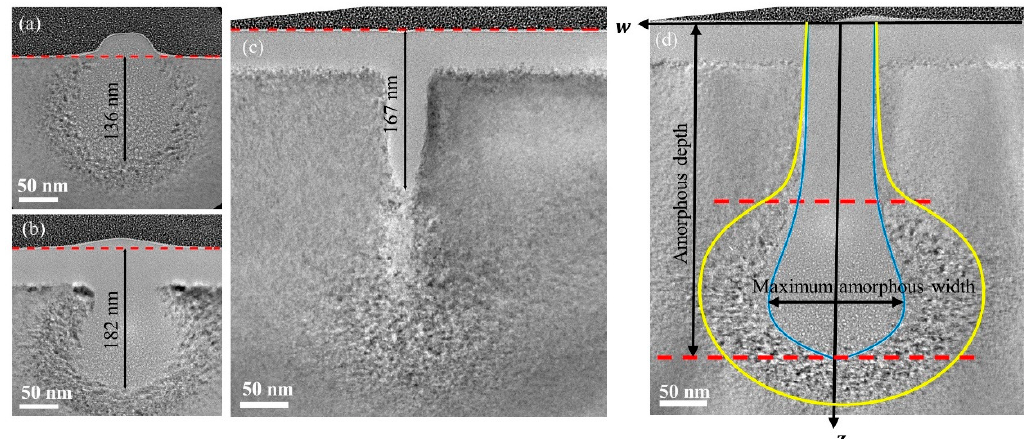
Figure 3. TEM images of cross-section samples of silicon substrate treated with He-FIB: ( a ) TEM image with an ion dose of 0.03 nC / µ m at a beam energy of 10 keV; ( b ) TEM image with an ion dose of 0.03 nC / µ m at a beam energy of 15 keV; ( c ) TEM image with an ion dose of 0.0075 nC / µ m at a beam energy of 35 keV; ( d ) TEM image with an ion dose of 0.035 nC / µ m at a beam energy of 35 keV.